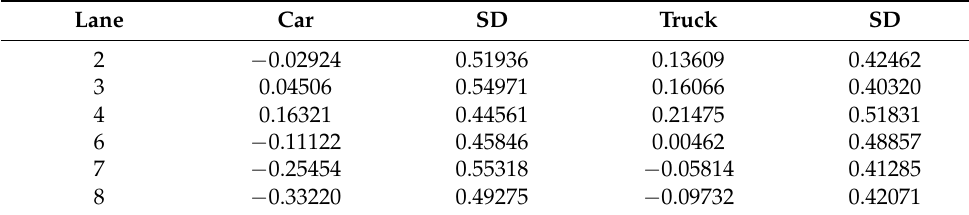
Table A3. The mean and standard deviation of